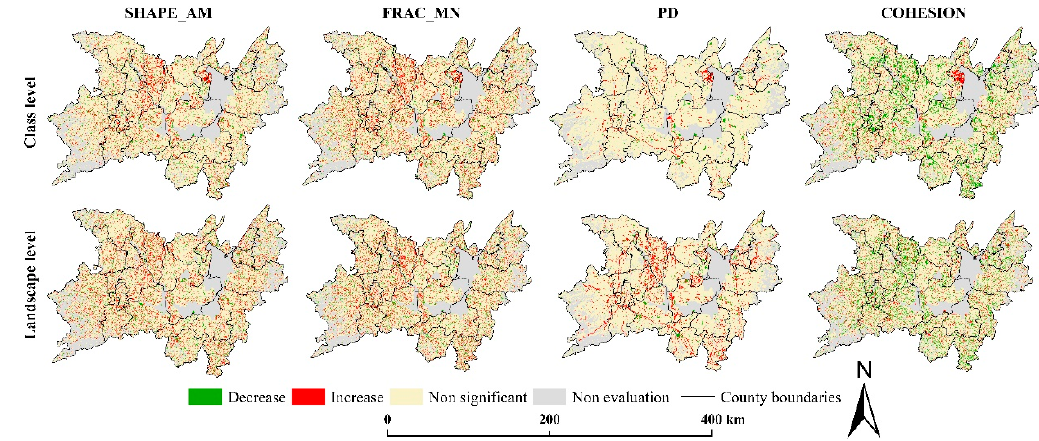
Figure 9. Trend analysis of landscape pattern index (SHAPE_AM, area-weighted mean shape index; FRAC_MN, mean fractal dimension index; PD, patch density; COHESION, patch cohesion index).